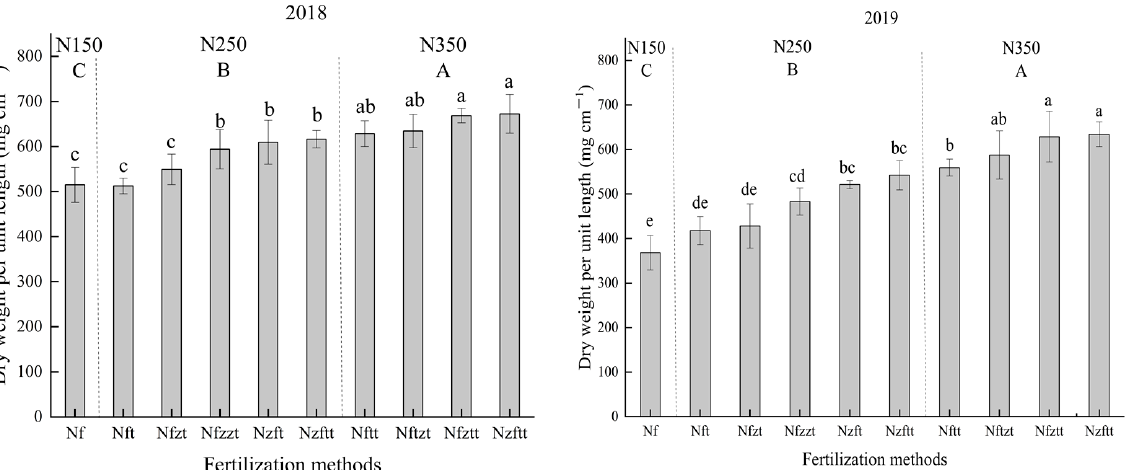
Figure 2. Effect of fertilization methods on rind penetration strength of the third elongation inter- node at silking stage, maturity stage, and harvest stage under different nitrogen application rates. N150, N250, and N350 refer to the nitrogen application rate being 150, 250, and 350 kg ha − 1 , respec- tively. “z” refers to the nitrogen application rate being zero, “f” refers to the nitrogen application rate being 150 kg ha − 1 , “t” refers to the nitrogen application rate being 100 kg ha − 1 , e.g., Nf refers to nitrogen application rate being 150 kg ha − 1 at sowing stage; Nfzt refers to nitrogen application rate being 150, 0, and 100 kg ha − 1 at sowing, 6-leaf, and 12-leaf stages, respectively; Nzftt refers to the nitrogen application rate being 0, 150, 100, and 100 kg ha − 1 at sowing, 6-leaf, 12-leaf, and silking stages, respectively. Capital letters indicate a significant difference at the p < 0.05 level under differ- ent nitrogen application rates. Lowercase letters indicate a significant difference at the p < 0.05 under all treatments.